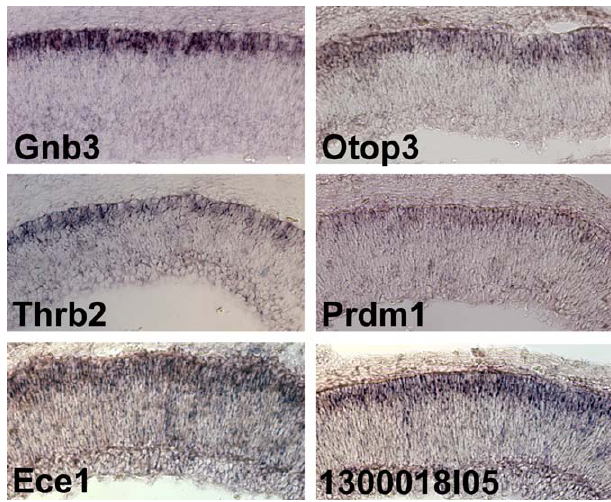
Figure 5. Some of the Genes Up-Regulated in rd7 Show an Early Photoreceptor Pattern of Expression Gnb3 and Thrb2 are both previously characterized cone genes that show staining at the scleral edge of the embryonic mouse retina in cells that will differentiate into photoreceptors. Ece1 and Otop3 are two novel cone genes identified in this study that were up-regulated in rd7 and also showed an early photoreceptor pattern of expression. Prdm1 and RIKEN cDNA 1300018I05 (Figure 1, genes G48 and G49, respectively) are two other genes that had either undetectable signal (Prdm1) or no apparent change in expression pattern in adult rd7 mutants (RIKEN cDNA 1300018I05), but which also showed staining in the embryonic retina in a presumptive photoreceptor pattern. All images are from E17.5 retina except Gnb3, which was from E16. DOI: